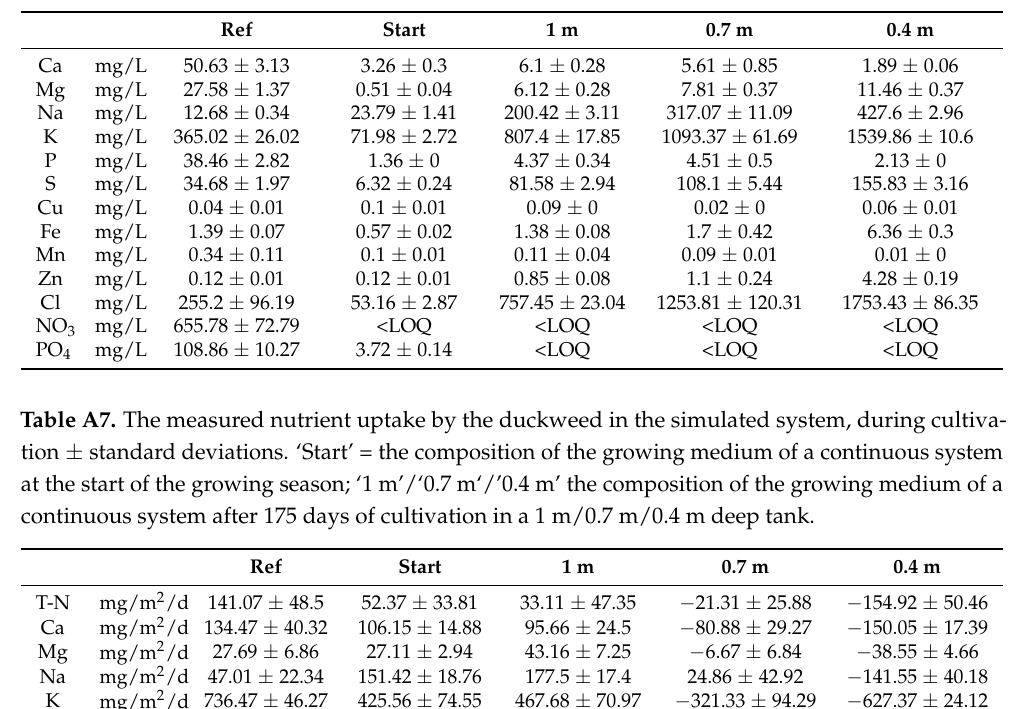
Table A6. The measured composition of the simulated nutrient concentration of the different growth media after the cultivation step in the experiment ± standard deviations (LOQ stands for limit of quantification). ‘Start’ = the composition of the growing medium of a continuous system at the start of the growing season; ‘1 m’/‘0.7 m’/‘0.4 m’ = the composition of the growing medium of a continuous